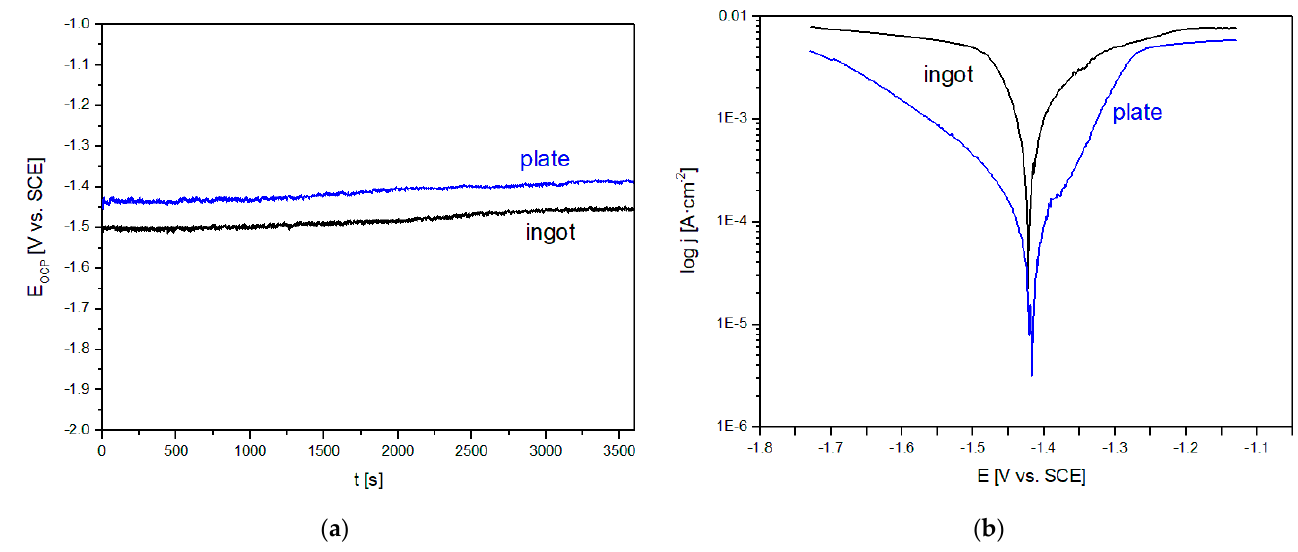
Figure 4. Changes of an open-circuit potential with time ( a ) and polarization curves ( b ) of Mg 60 Zn 20 Ca 2.6 Yb 15.7 Sr 1.7 alloy in a form of ingots and